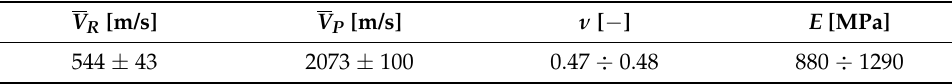
Table 4. Estimation of elastic parameters of masonry panel.